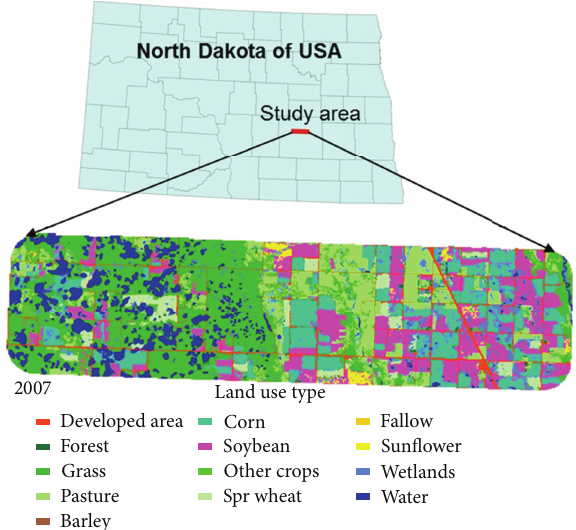
Figure 1: Location of the study area and the spatial distribution of its land cover types in